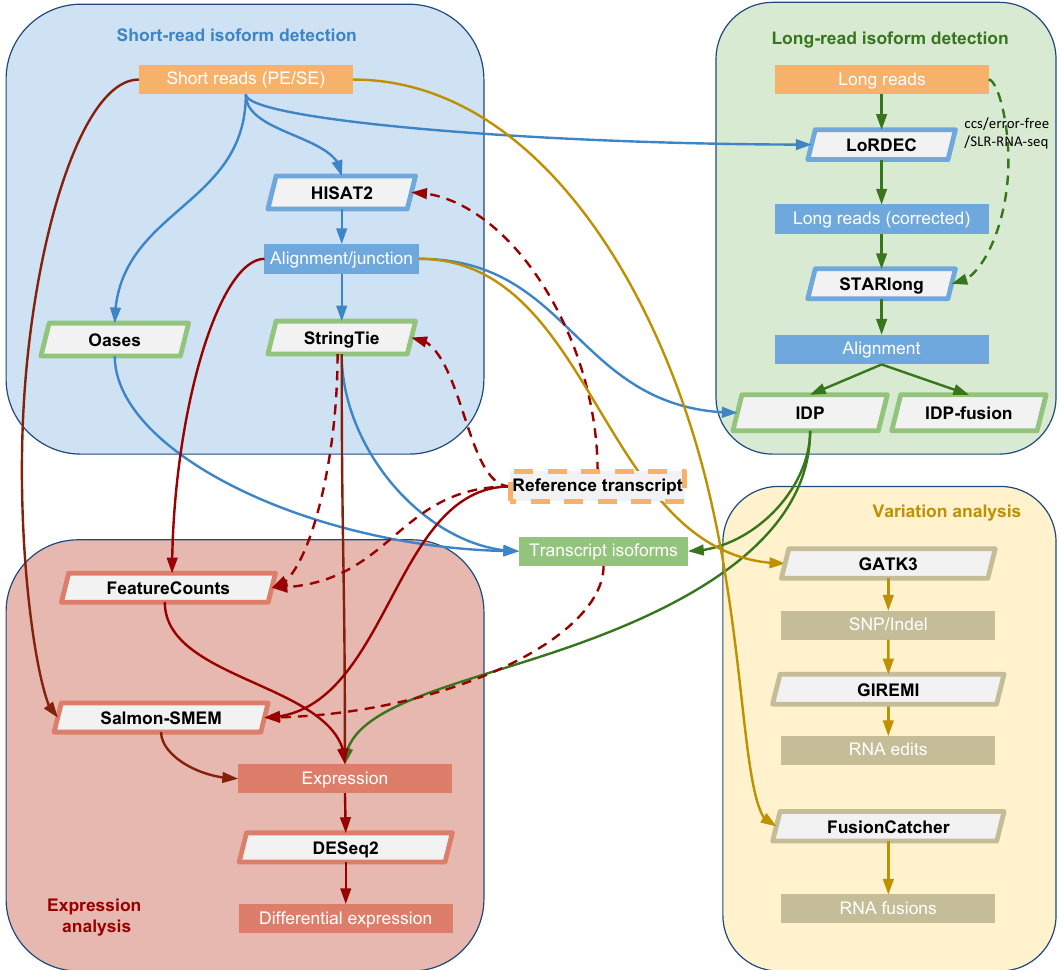
Fig. 8 The current RNACocktail computational pipeline. The pipeline is composed of high-accuracy tools in each step for general-purpose RNA-seq analysis NATURE COMMUNICATIONS | 8: